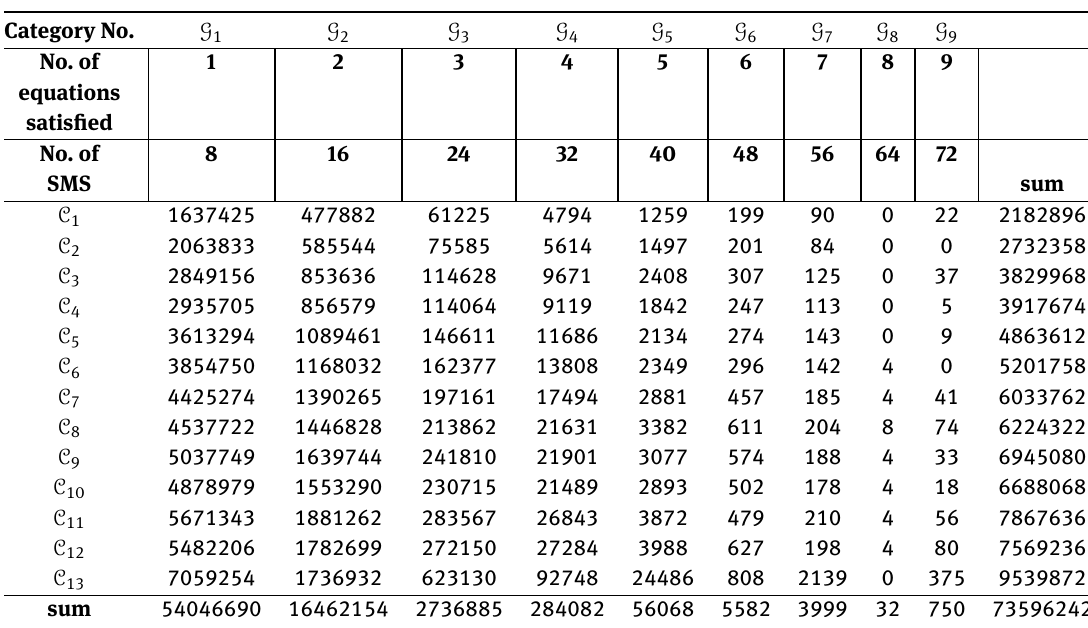
Table 3: The number of basic forms in M i , j , C i and G j Category